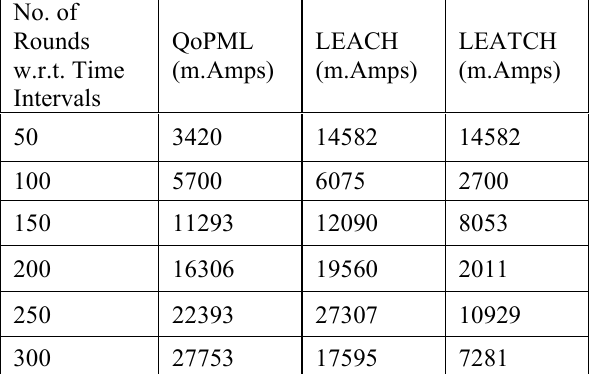
Table 2. Energy results with respect to node communication